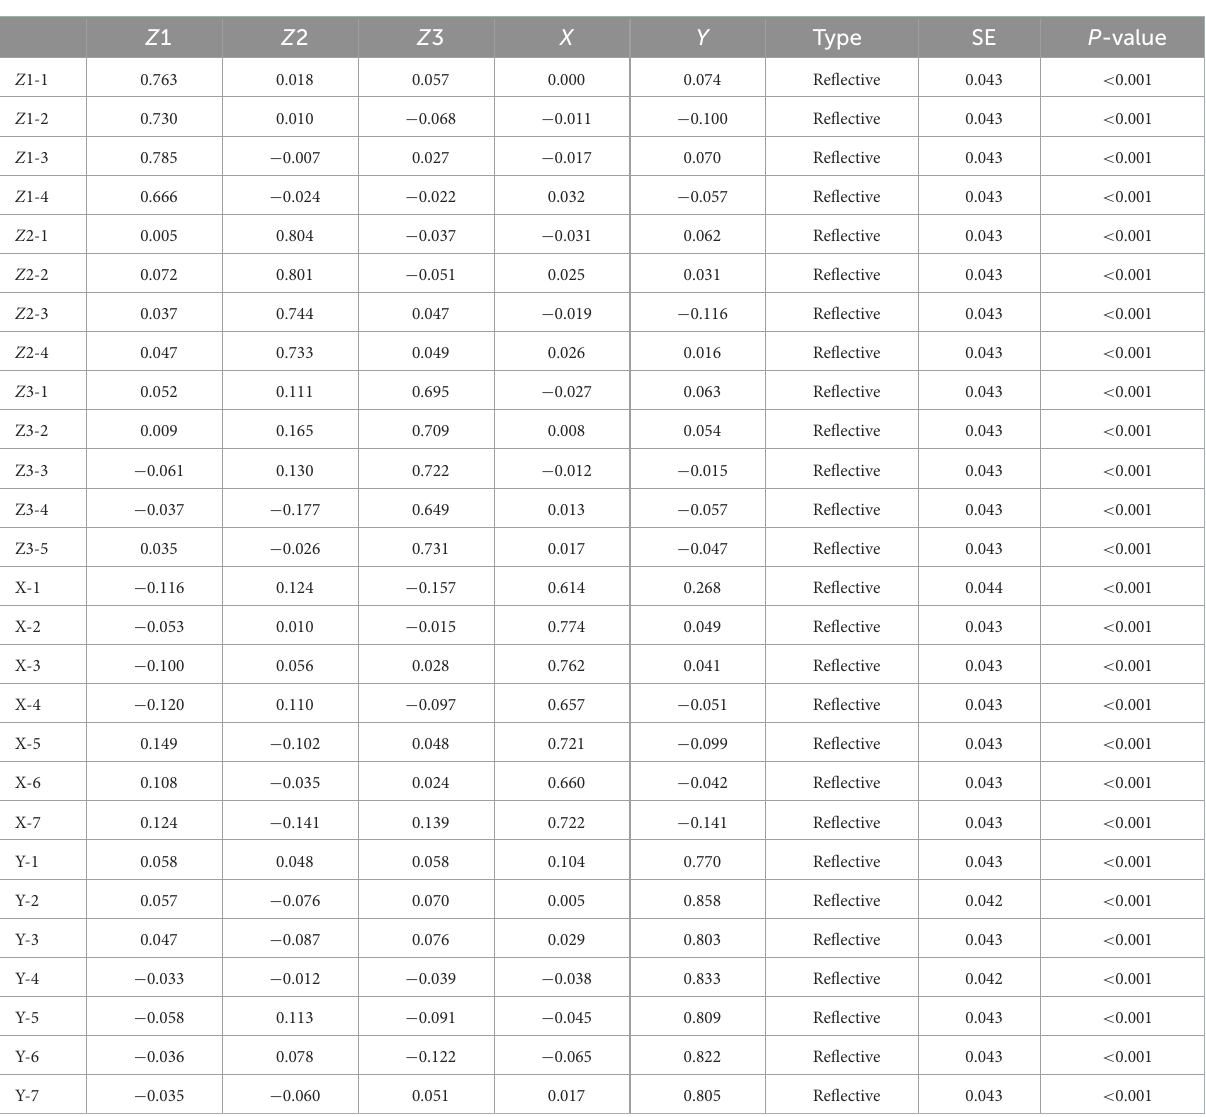
TABLE 2 Combination of loadings and